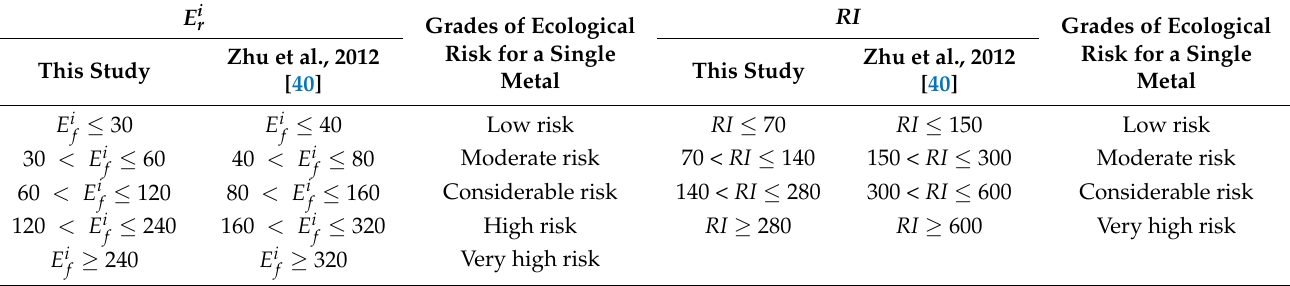
Table 2. Relationship between potential ecological hazard index and potential ecological hazard